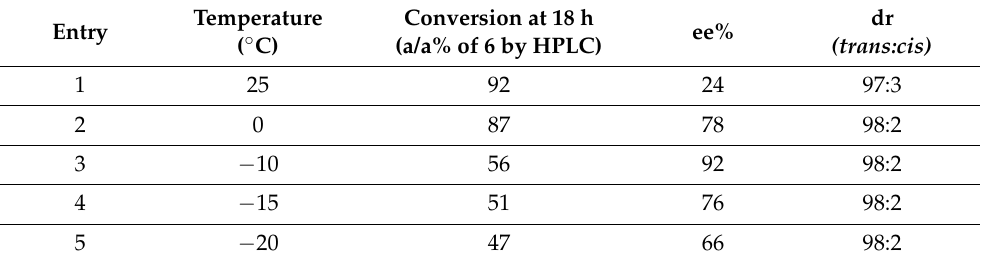
Table 4. Examining the effect of temperature using catalyst 26aS at 10 mol% in